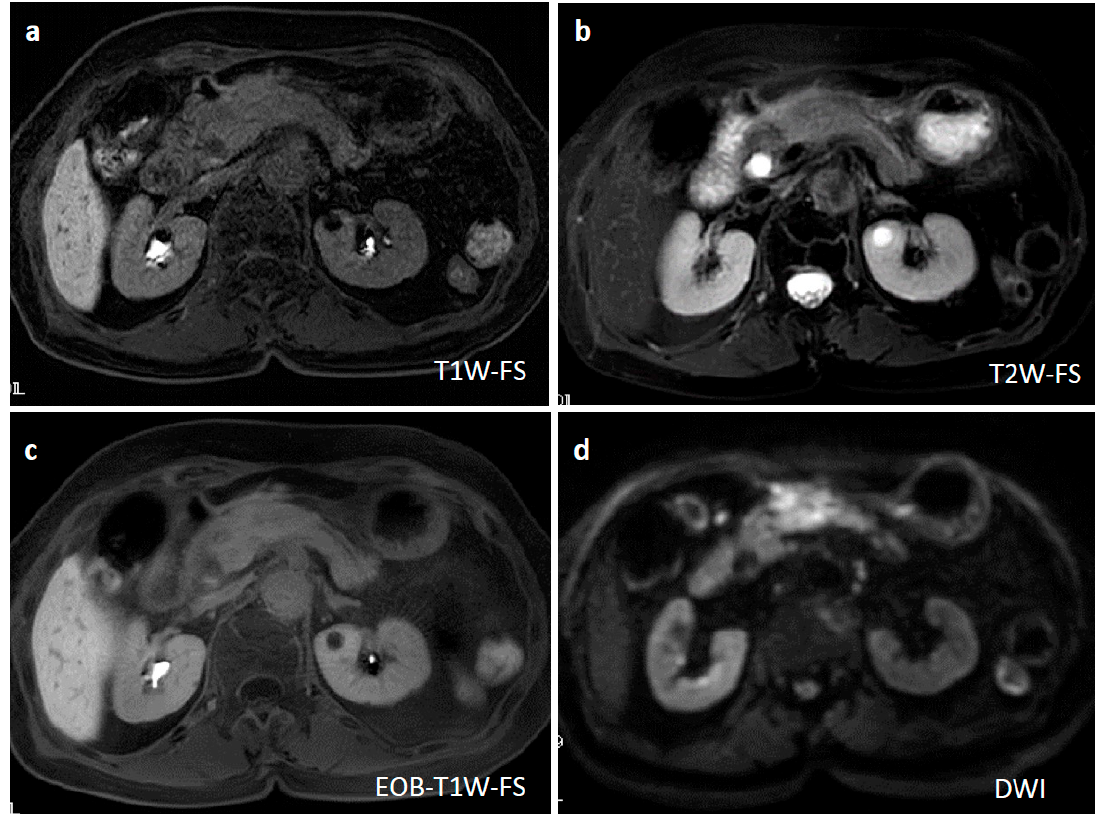
Figure 6. Magnetic resonance imaging (MRI) at two weeks after EUS-FNAB and three weeks after the initial CT. A T1-weighted MRI showed an iso-intensity signal ( a ), a T2-weighted image showed a faint low-intensity signal ( b ), a gadoxetate sodium-injected MRI demonstrated a slightly weak enhancement ( c ), and a di ff usion-weighted MRI revealed heterogeneously repressed di ff usion ability at the